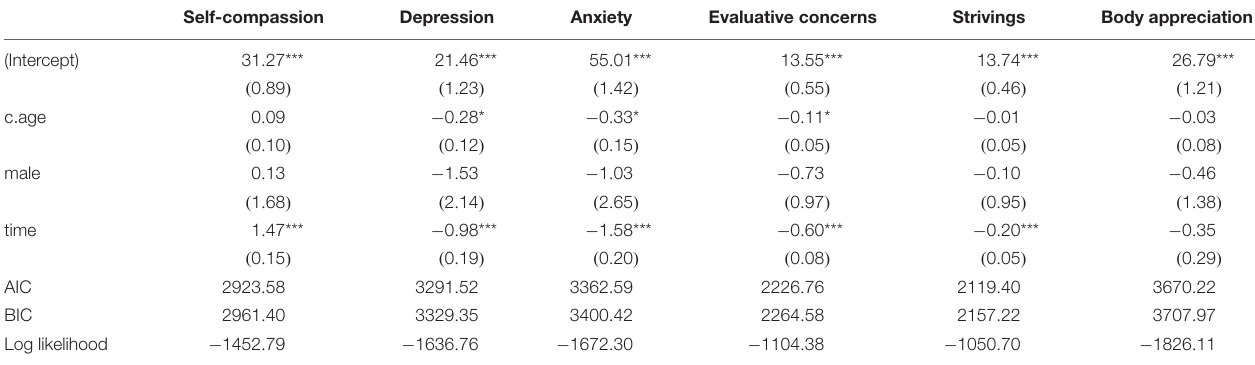
TABLE 1 | Mixed level model of changes in mental health outcomes over